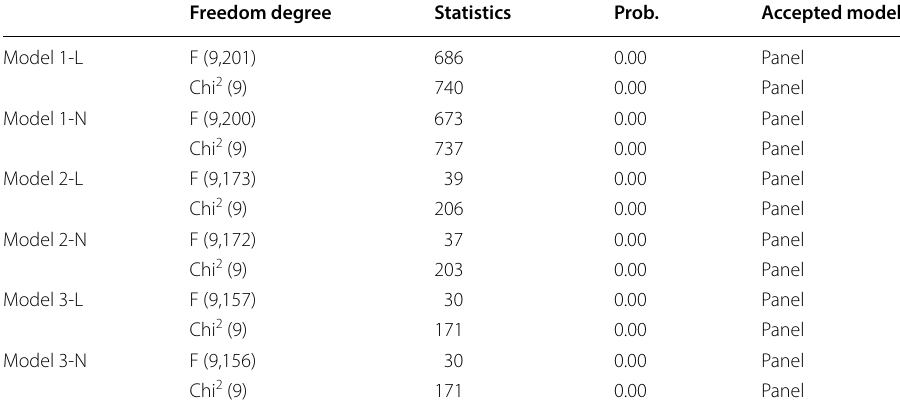
Table 2 F-Limer statistic for the panel-pooled model dilemma